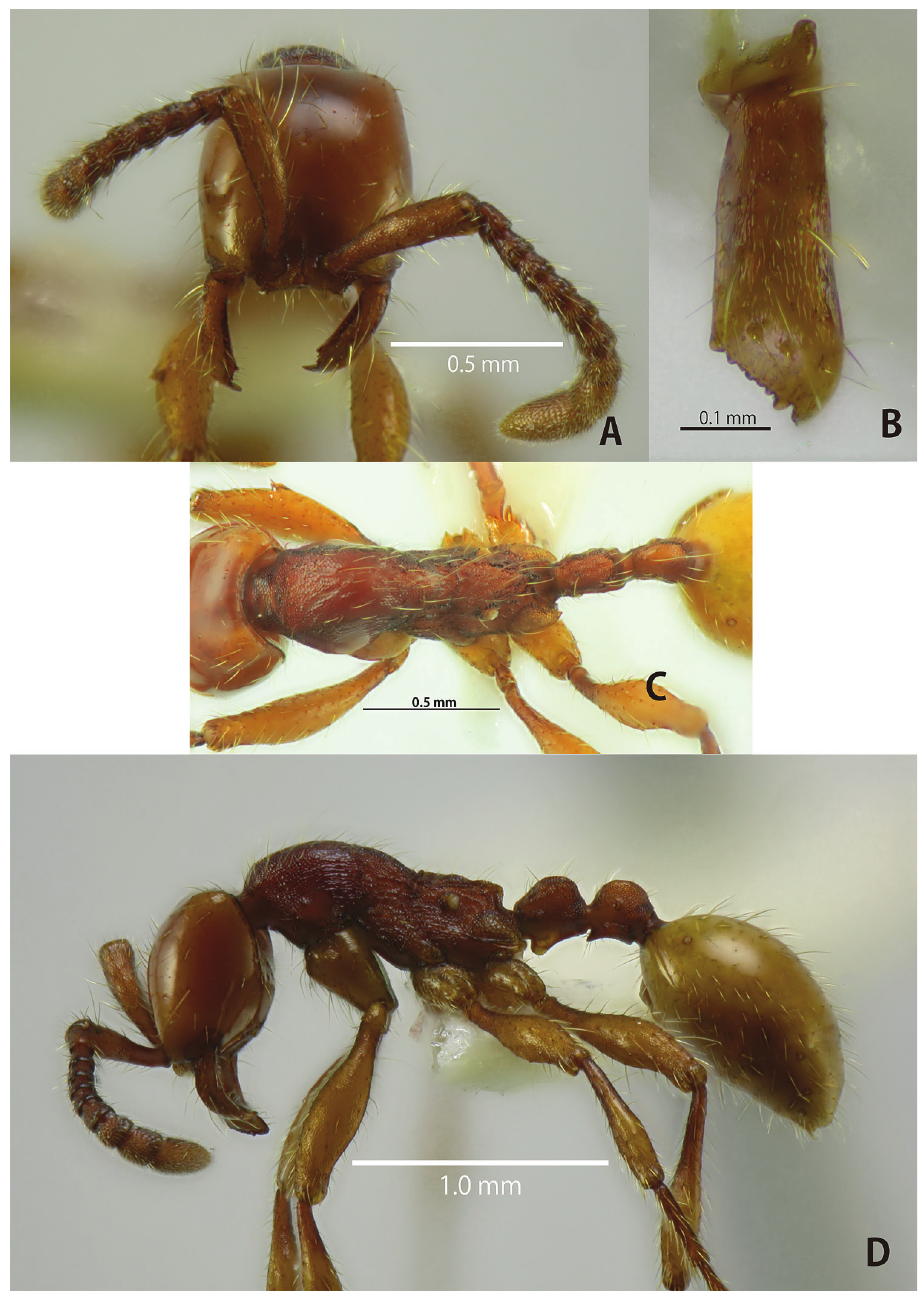
Figure 17. Aenictus thailandianus (specimens from the type locality). A Head in full-face view B mandible C body in dorsal view D body in